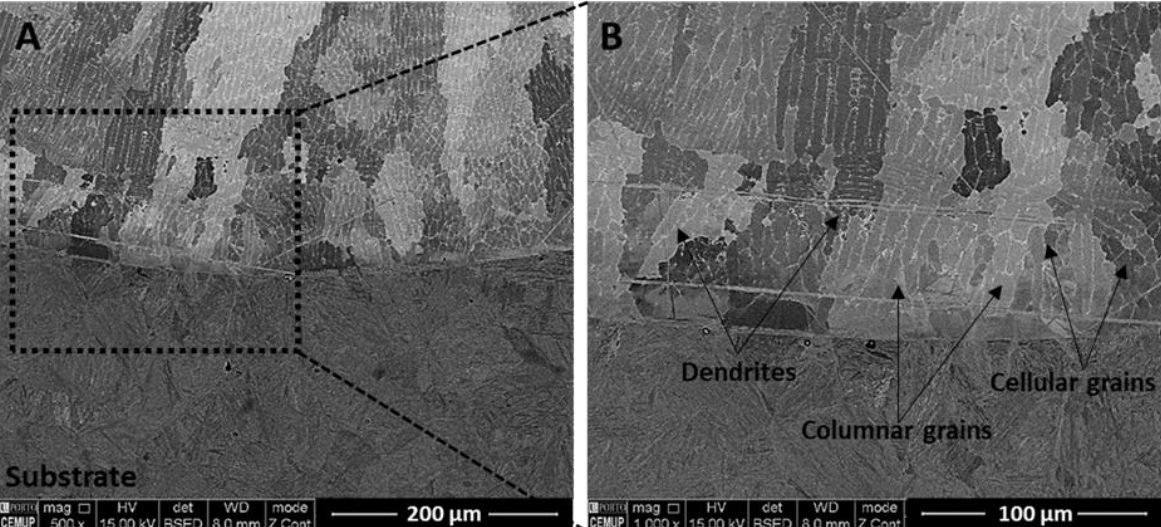
Figure 10. Microstructure of cladding produced by the I2_6_20 cladding condition on the preheated substrate, showing ( A ) substrate interface cladding zone. ( B ) A higher magnification illustration of the interface.